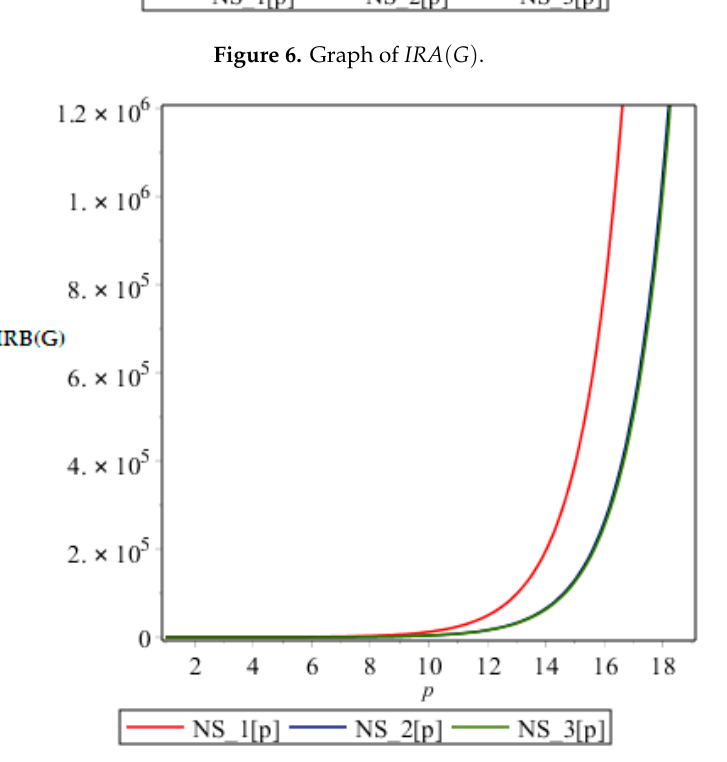
Figure 7. Graph of IRB ( G ) Figure 7: Graph of 𝐼𝑅𝐵(𝐺) . Figure 7: Graph of 𝐼𝑅𝐵(𝐺) .